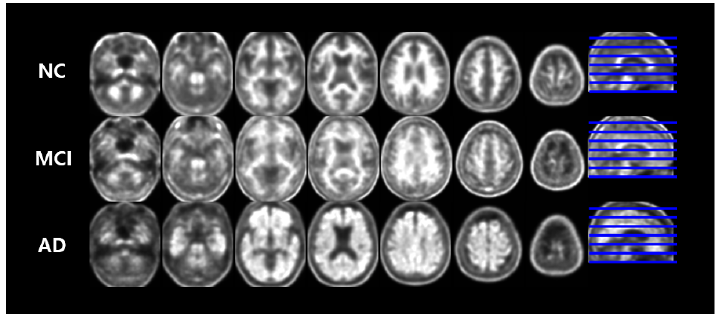
Figure 5. Multi-slices of pre-processed 18F-Florbetaben imaging by disease group. Each column shows 7 axial planes observed at equal intervals, and a sagittal plane. The blue lines represent the extracted level of each axial